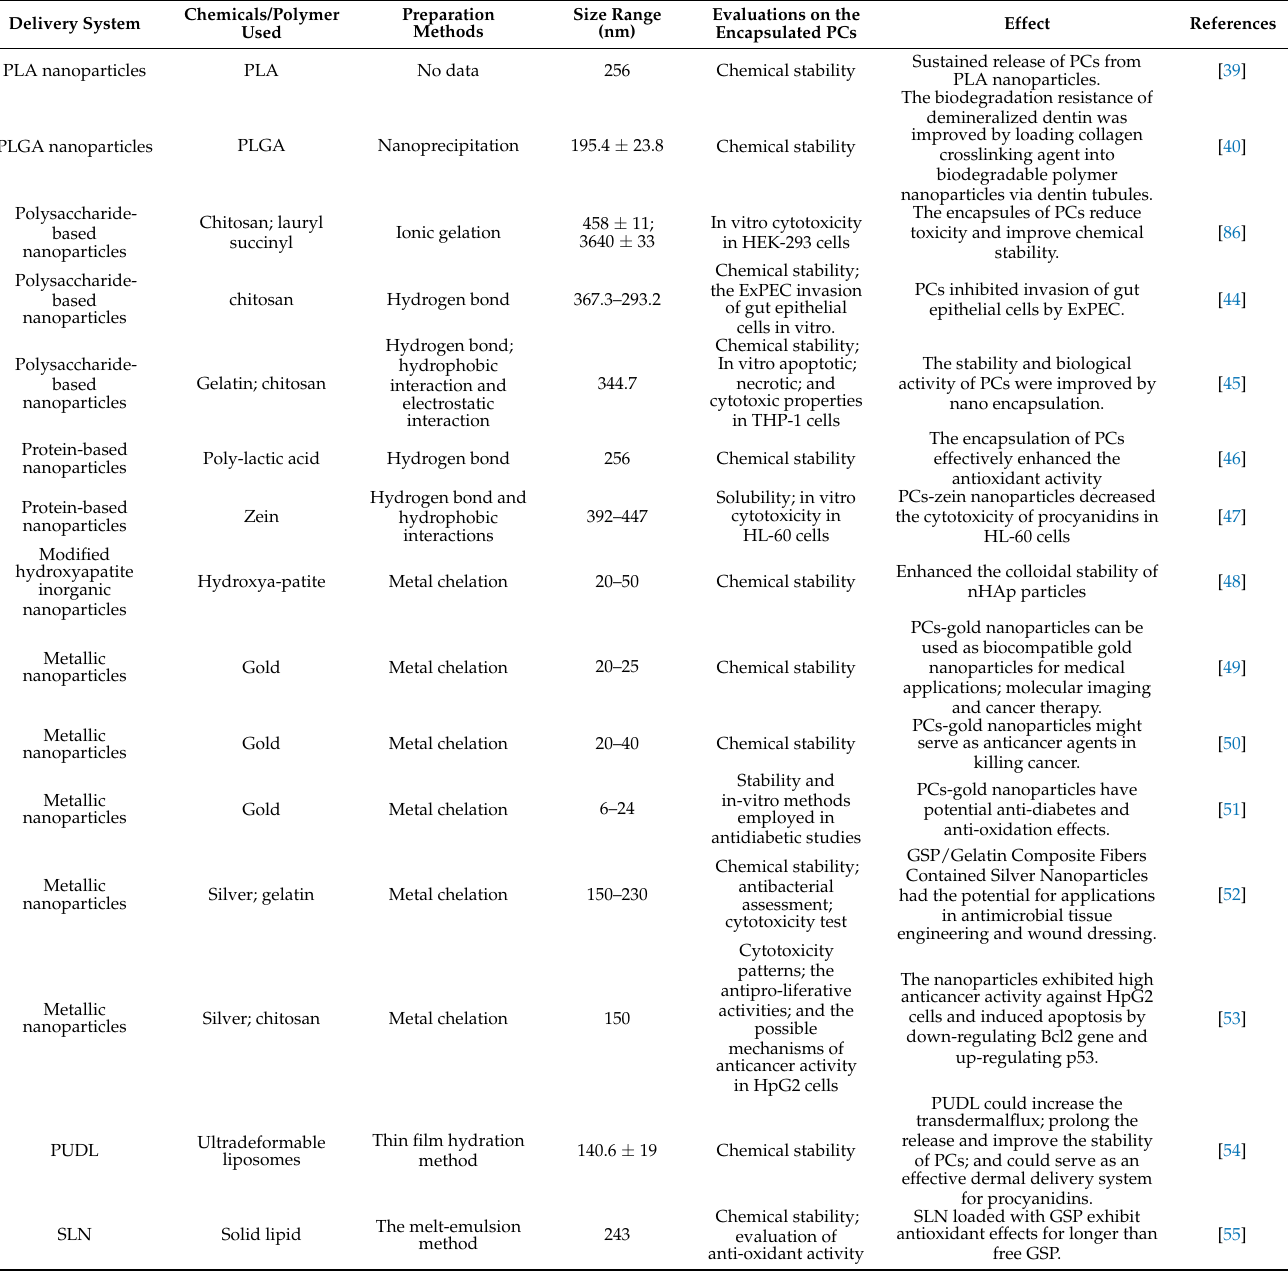
Table 1. The physico-chemical characters of different PCs delivery